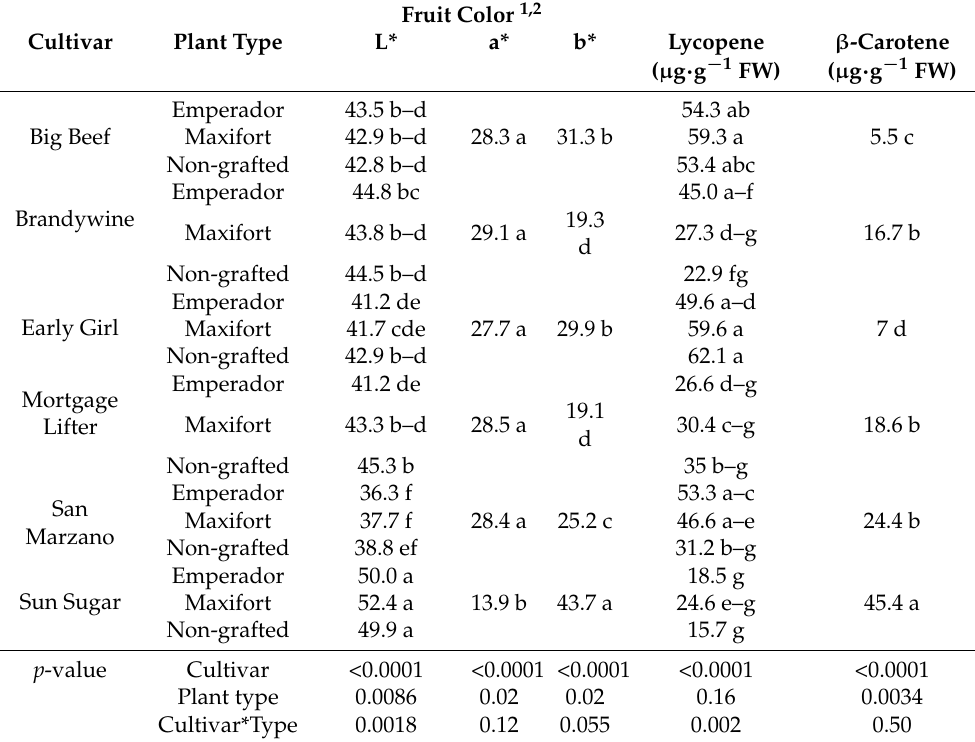
Table 6. Fruit quality parameters of six tomato cultivars when grafted onto two types of rootstocks or grown non-grafted in a high tunnel during the 2020 growing